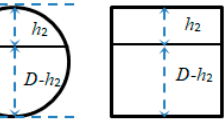
Figure 4. Extreme 2: different material thicknesses.